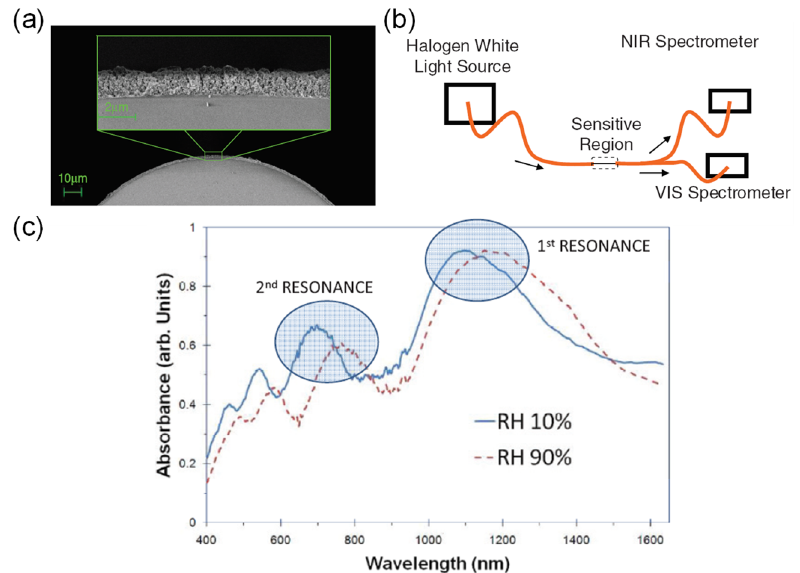
Figure 16. Point sensor. ( a ) SEM image of the coating on the fiber. ( b ) Experimental setup. ( c ) Spectral response to different RH levels. Adapted with permission from ref. [67]. Copyright 2011 Elsevier